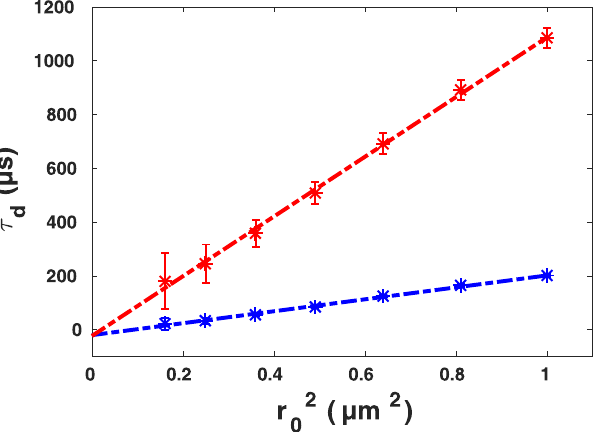
02 with Pearson d